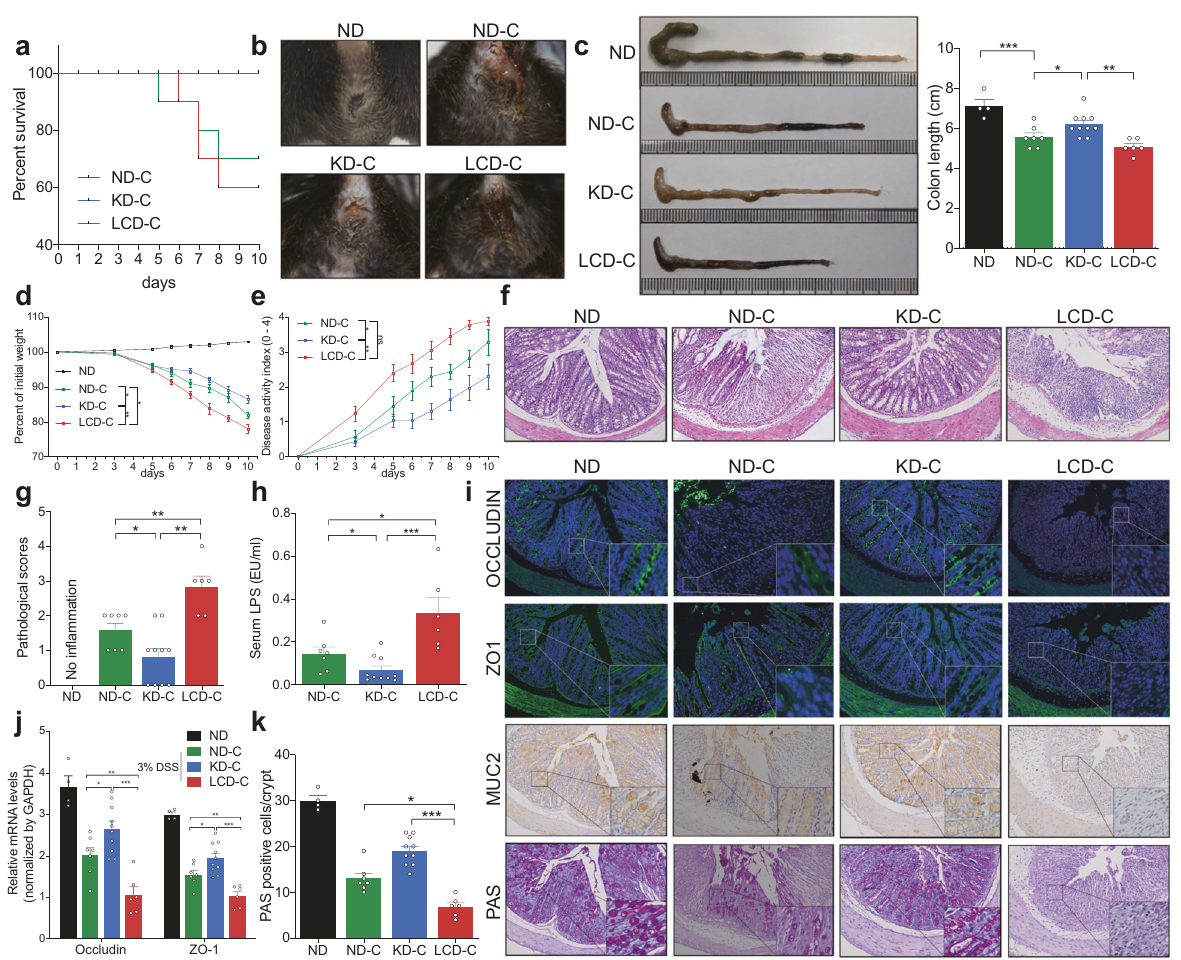
Fig. 3 KD alleviates in fl ammatory responses and protects mucosal barrier function in mice with colitis. a Survival curves of mice with DSS- induced colitis fed with a KD, LCD, or ND. b Representative images of bloody diarrhea. c Representative images of the colon at 1.5 weeks after DSS induction. Colon length shown as a chart. d Body weight change in mice receiving 3% DSS in drinking water. e DAI in each group. f Representative colon H&E staining images (original ×magni fi cation 200). g Changes in colonic section pathological scores. h Serum LPS levels detected by end-point chromogenic tachypleus amebocyte lysate. i Representative images of immuno fl uorescence, IHC and PAS staining in colon tissues with antibodies against Occludin, ZO-1, and MUC-2 (original magni fi cation ×200). j Colon Occludin and ZO-1 mRNA expression measured by qRT-PCR. k Number of PAS-positive cells per villus/ crypt. * p < 0.05; ** p < 0.01; *** p < 0.001. (KD-C, n = 10; LCD-C, n = 6; ND-C, n = 7; ND, n = 4). Results are expressed as mean ± SEM ( c – e , g , h , j , k ). KD ketogenic diet, LCD low-carbohydrate diet, ND normal diet, DSS dextran sulfate sodium, LPS lipopolysaccharide, IHC immunohistochemistry, PAS periodic acid the KD-C group while Escherichia/Shigella were enriched in the LCD-C group (Supplementary Fig. 2b, c). Finally, KEGG pathway analysis suggested that the microbiota in the MLNs of the LCD-C group were involved in bacterial motility and lipopolysaccharide biosynthesis, while those in the KD-C group were involved in pentose and glucuronate interconversion, carbohydrate metabo- lism, glycolysis, and gluconeogenesis (Fig. 5h). FMT from KD- and LCD-fed mice affects in fl ammation